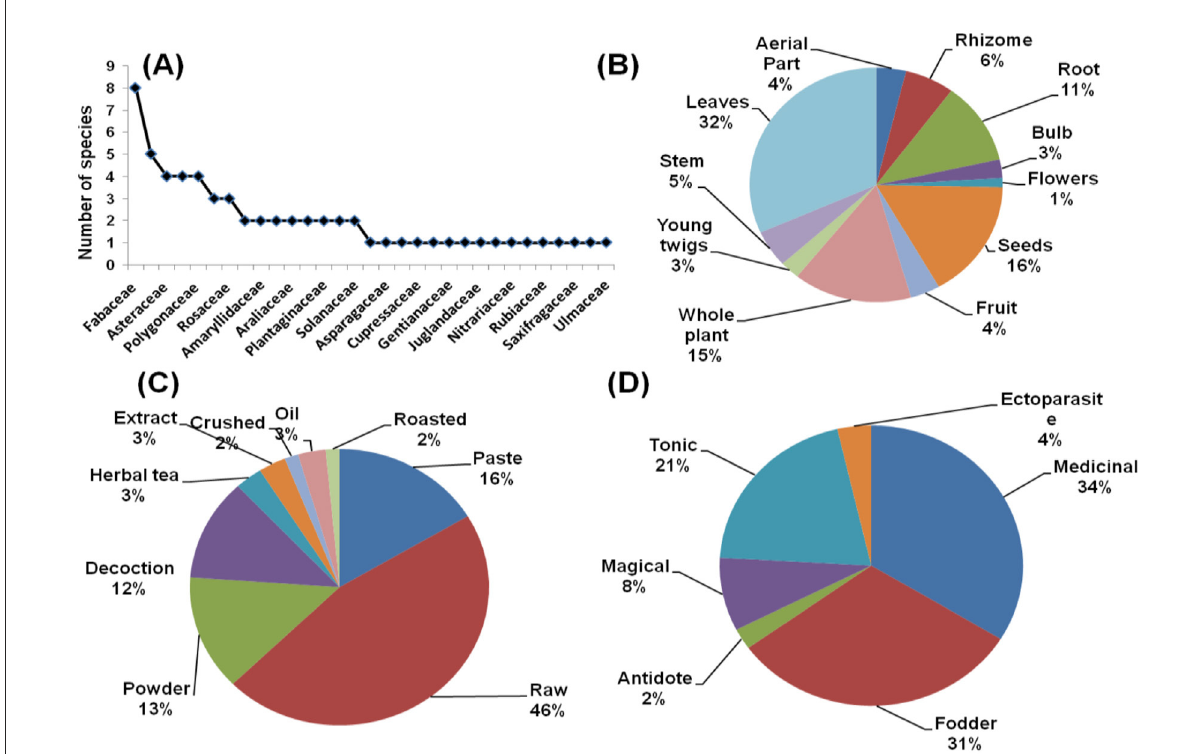
FIGURE3 (A) Species family relationship (B) part used (C) form of preparation (D) ethno-veterinary usage of plants from Kashmir